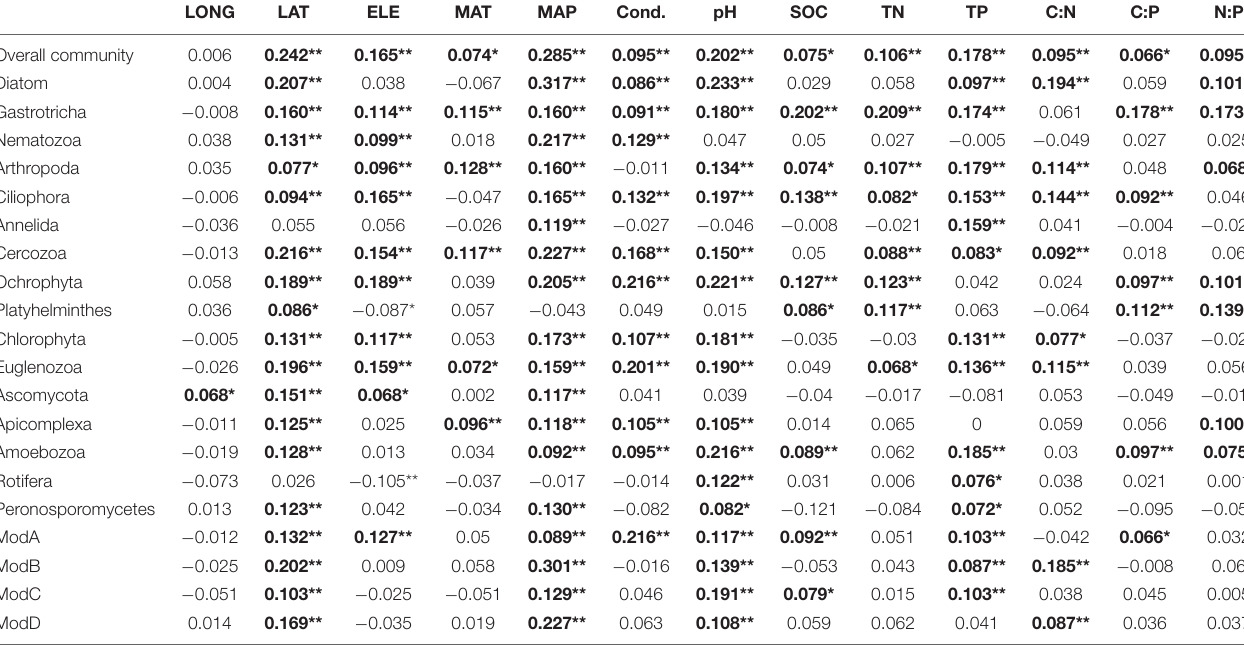
TABLE 1 | Mantel tests between environmental factors and micro-eukaryotic communities (overall, dominant phyla, and network modules). LONG LAT ELE MAT